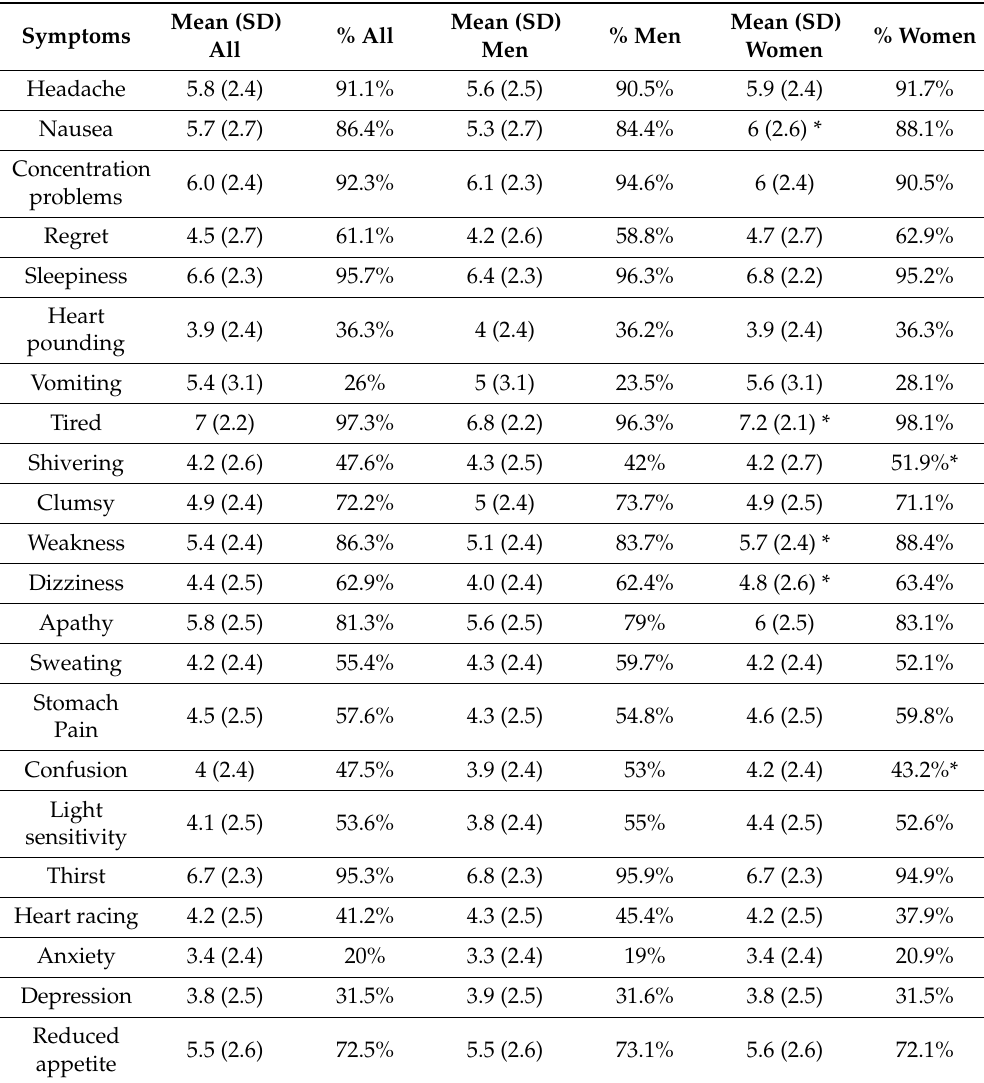
Table 5. Presence and severity of individual hangover symptoms after alcohol consumption and reaching an eBAC of 0.11% ≤ eBAC <